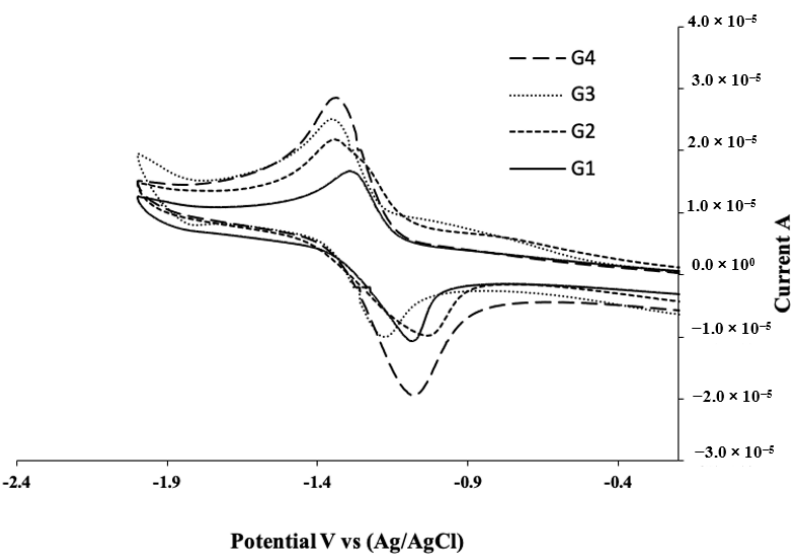
Figure 5. Representative cyclic voltammogram for G1-D3-Asp , G2-D6-Asp , G3-D9-Asp , G4-D12-Asp in 0.1 M Bu 4 NPF 6 in propylene carbonate.